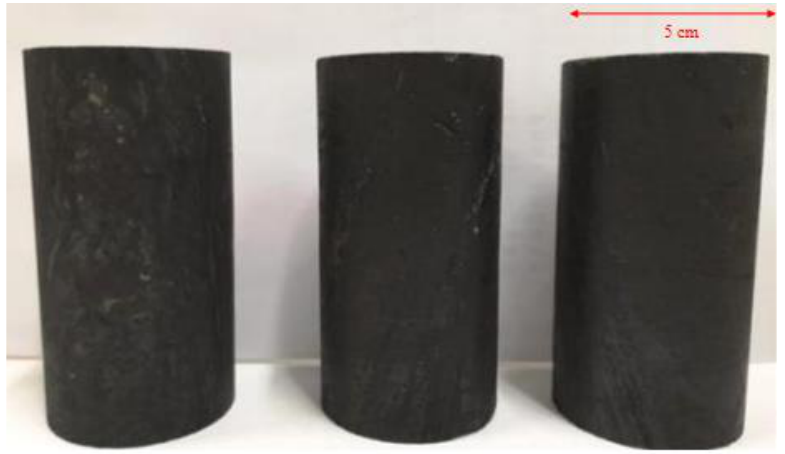
Figure 1. Specimens for static compression test.